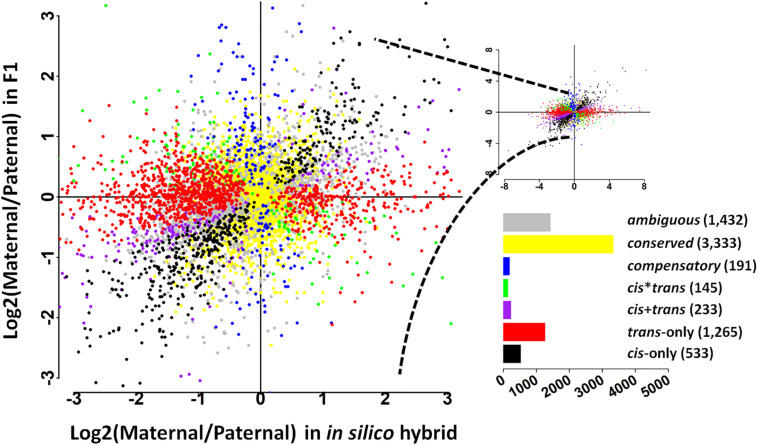
Plot summarizes the relative, allele-specific expression levels in parental (in silico hybrid) and the F1 hybrids. Each gene is shown as a point which is color-coded according to the pattern of regulatory divergence. The bar graph depicts the total number of genes in each pattern.